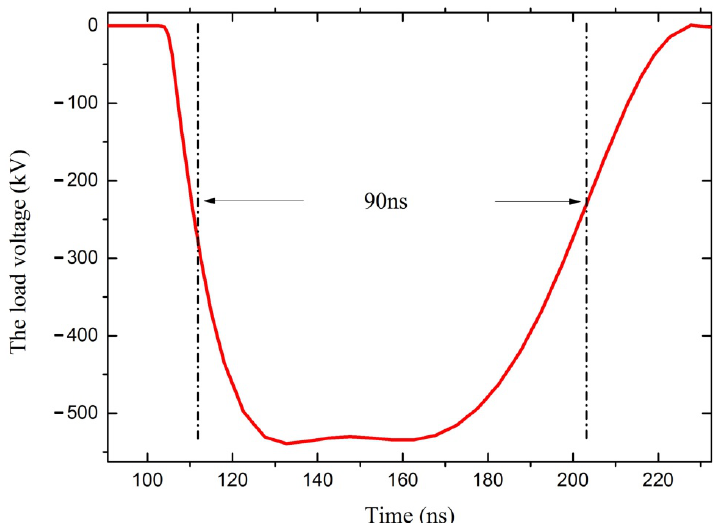
Figure 2. The load voltage waveform in simulation.